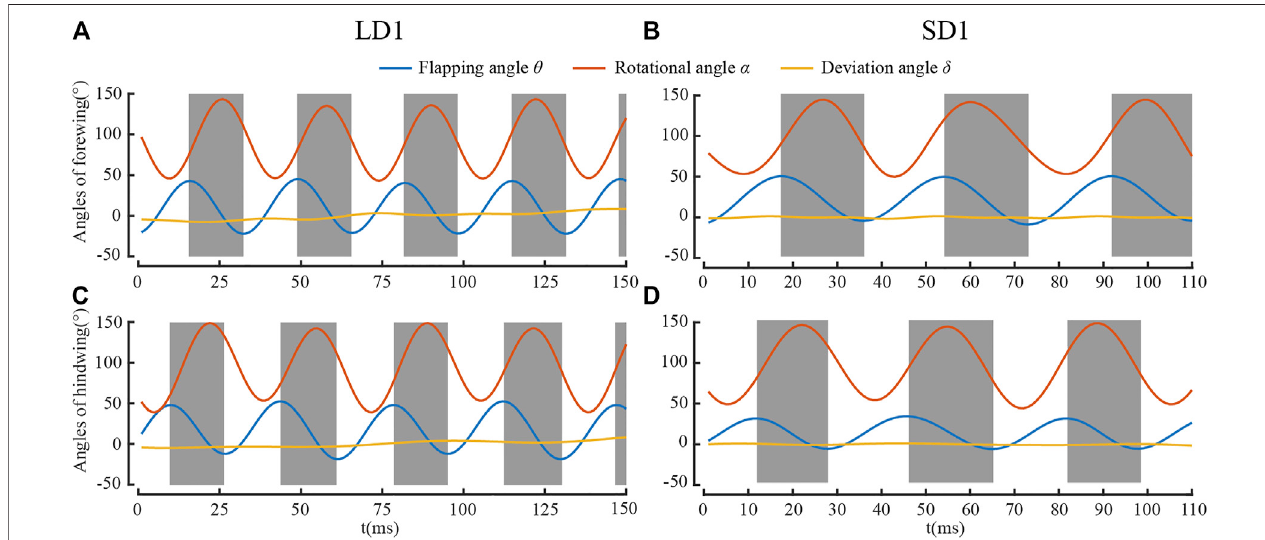
FIGURE 5 | Euler angles for (A) forewing during LAC; (B) forewing for SAC; (C) hind wing for LAC; and (D) hind wing for SAC.